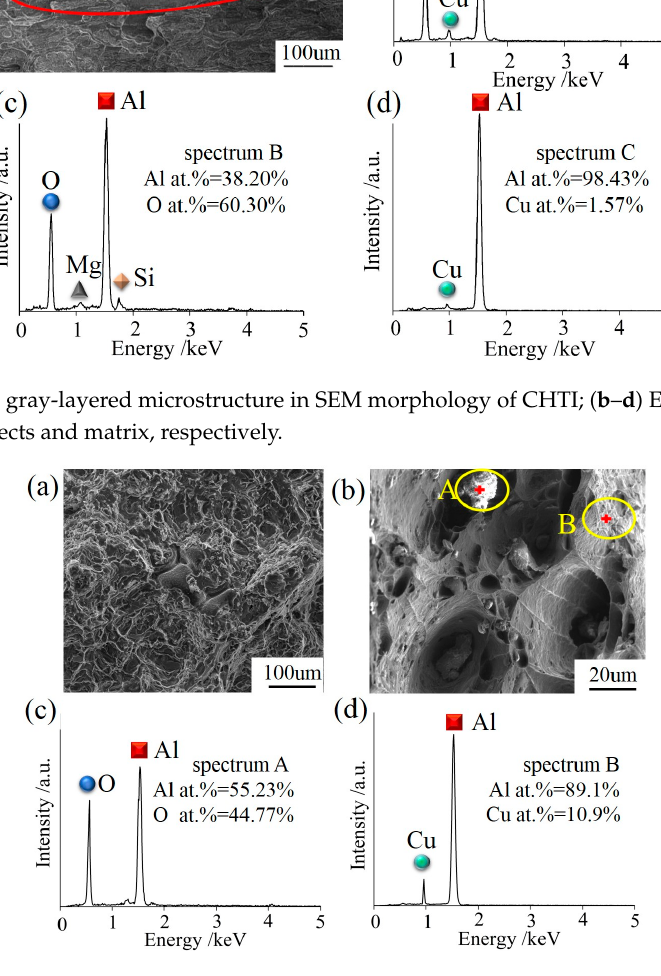
Figure 8. ( a ) SEM morphology of the fracture microstructure in UHTI; ( b ) particle morphology and